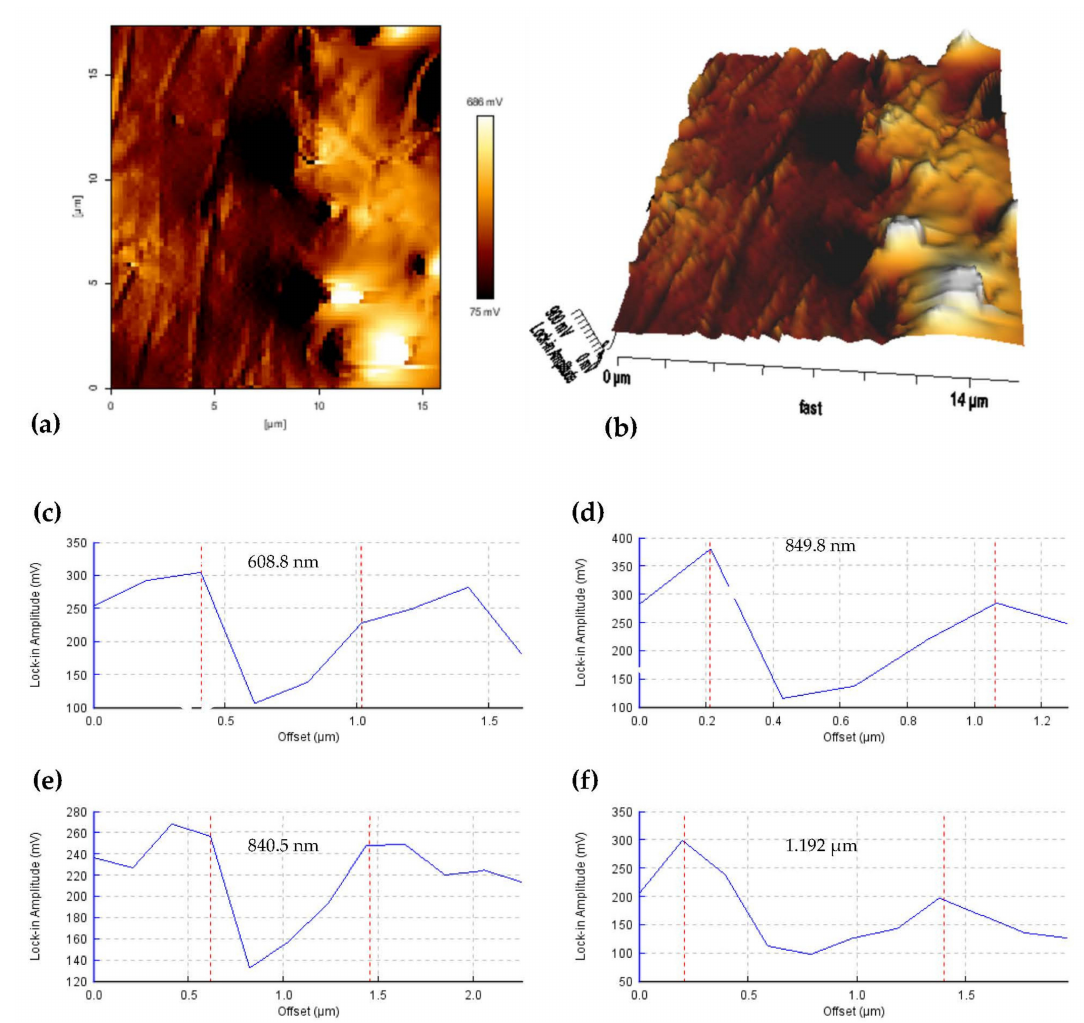
Figure 6. AFM amplitude topography image of the shear band deformation in the MRE matrix ( a ) nearly parallel and compounded interrelation shear bands; ( b ) three-dimensional topographic image of the shear band deformation. The red double-headed arrow represents the microphase separation. The bottom lock-in amplitude cross-sectioned graphs show the spacing thickness of the deformed shear band ( c ) the thinnest shear band of 608.8 nm ( d ) regular thickness value of 849.8 nm; ( e ) regular thickness value of 840.5 nm and ( f ) the thickest shear band of 1.192 µ